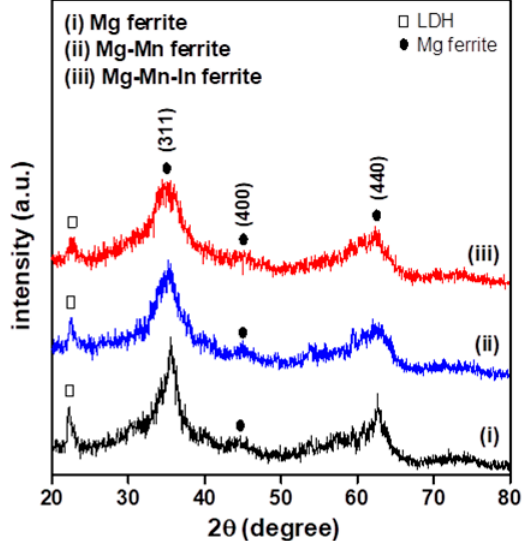
Figure 1. X-ray diffraction ( XRD) patterns of Mg, Mg-Mn, and Mg-Mn-In ferrite nanoparticles synthesized by hydrothermal method. synthesized by hydrothermal